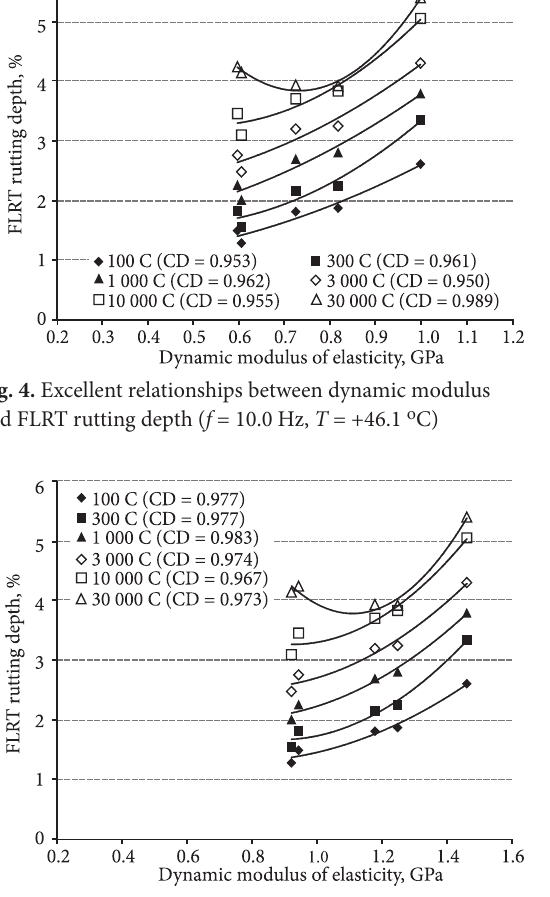
Fig. 3. Excellent relationships between dynamic modulus and FLRT rutting depth ( f = 5.0 Hz, T = +46.1 o C)